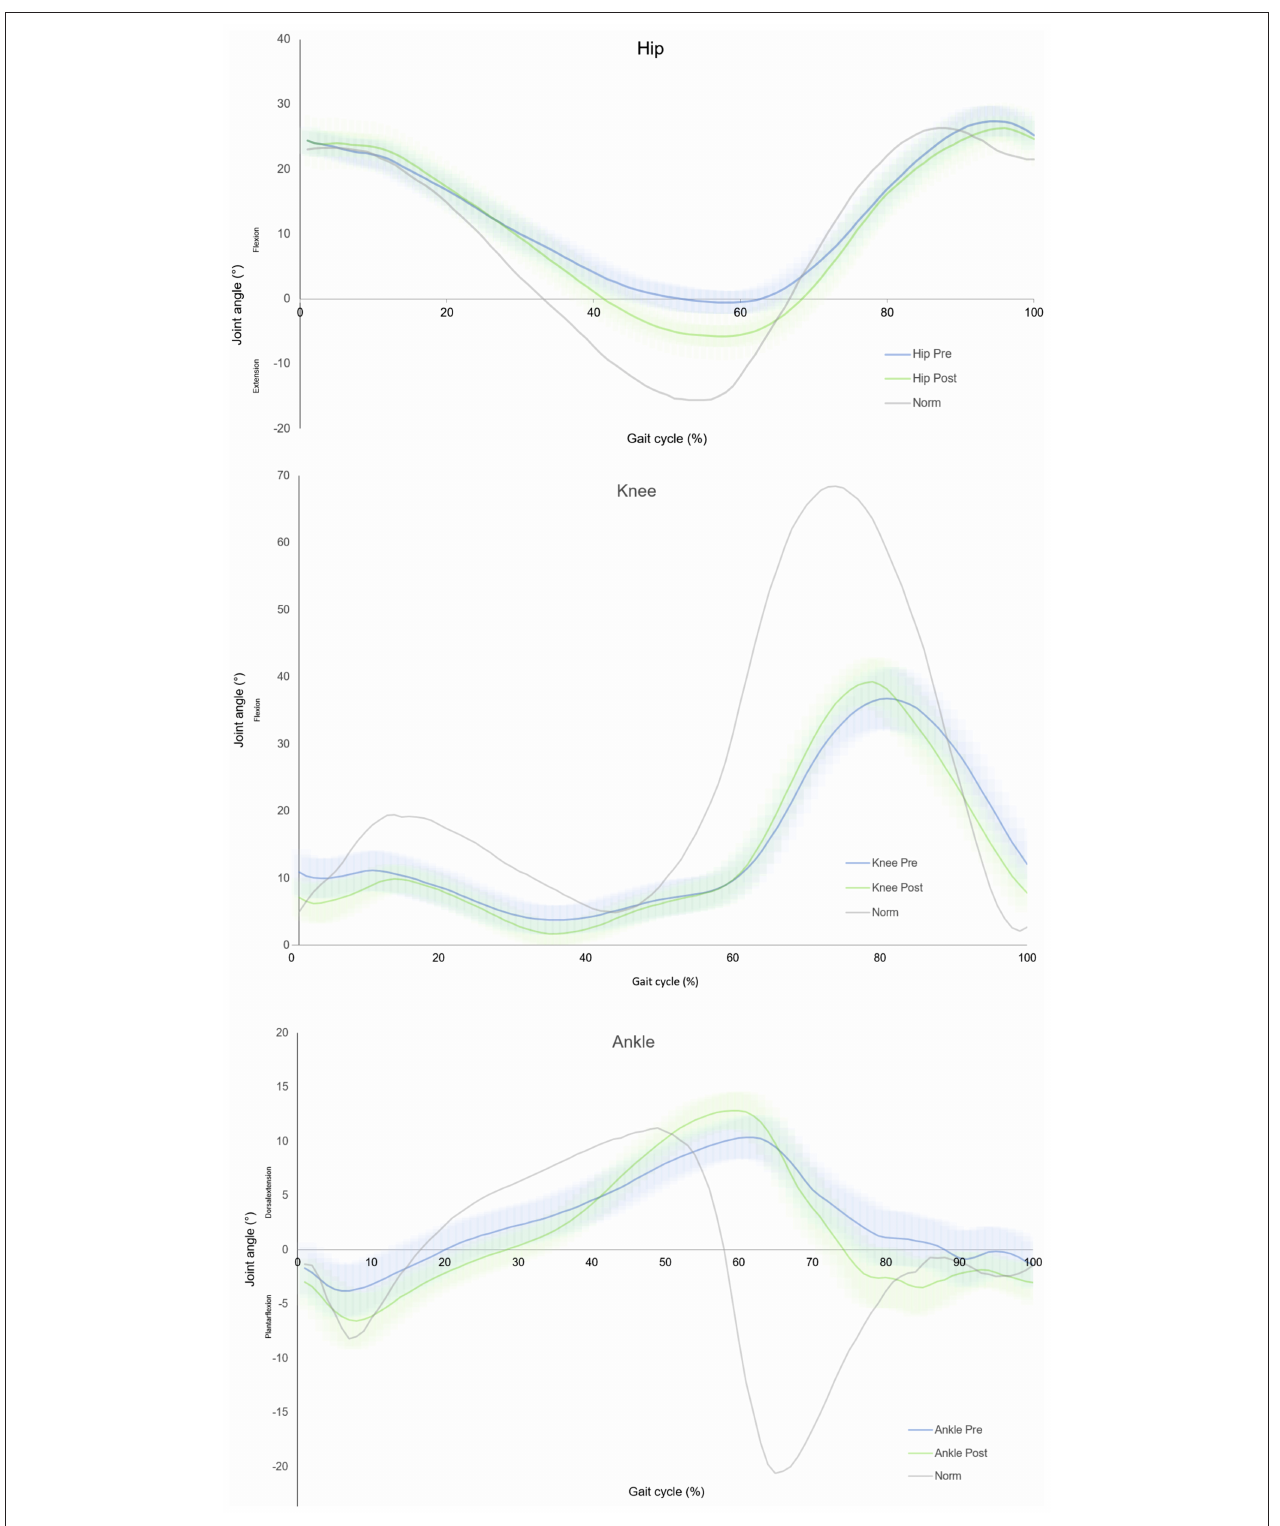
FIGURE 3 | Sagittal plane joint angles over all individuals of hip, knee and ankle.